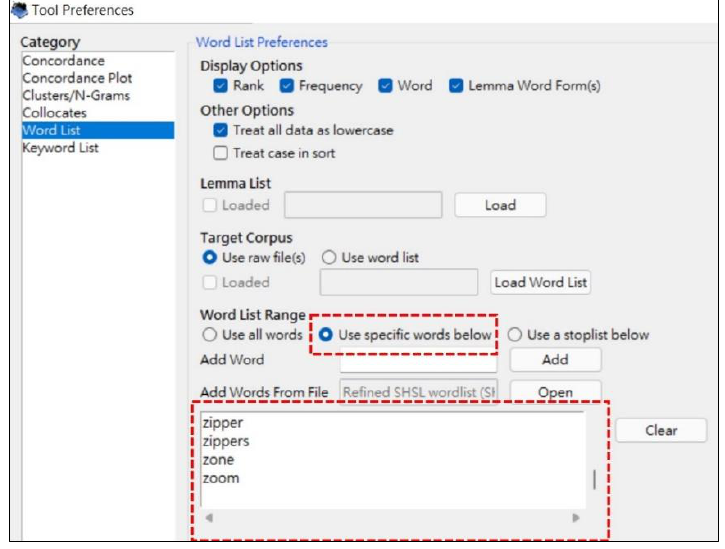
Figure 9. Set CEFR B1 level word list as “specific words”.